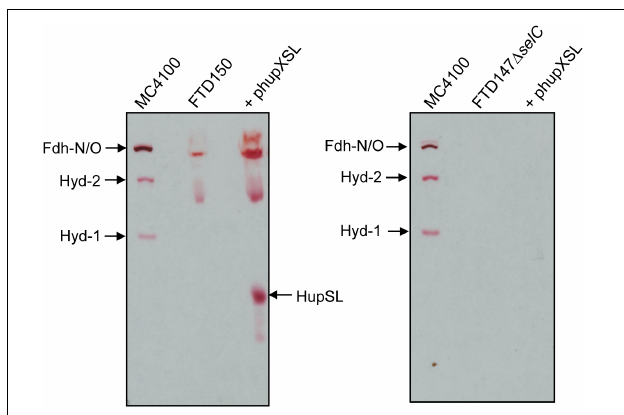
FIGURE 3 | Appearance of HupSL enzyme activity is dependent on a functional selenocysteine biosynthetic apparatus. Crude extracts (100 µ g of protein, except M4100 where 30 µ g of protein were applied) of the indicated strains were separated in native-PAGE and stained for hydrogenase enzyme activity as described in the legend to Figure 1 . Strains used include: MC4100 (wild type); FTD150 ( (cid:49) hyaB (cid:49) hybC (cid:49) hycE (cid:49) hyfG ); FTD147 (cid:49) selC ( (cid:49) hyaB (cid:49) hybC (cid:49) hycE (cid:49) selC